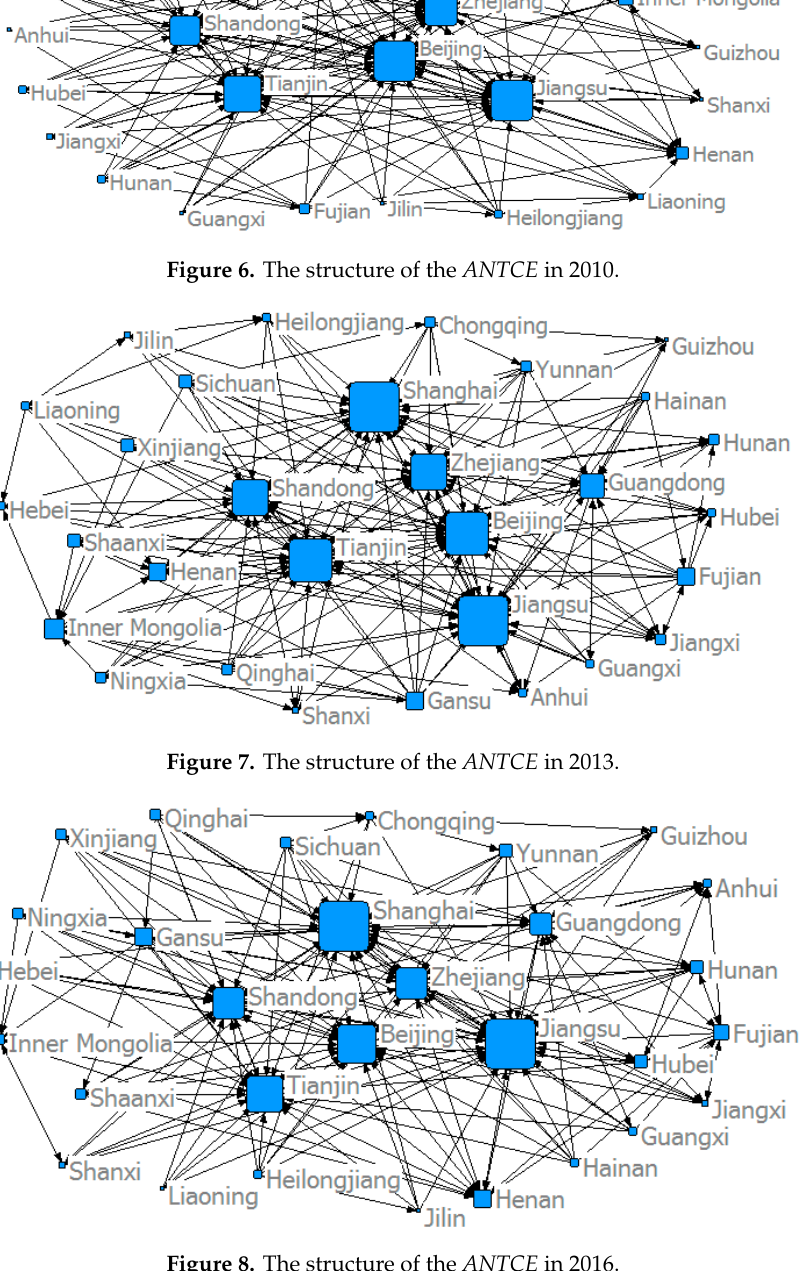
Figure 8. The structure of the ANTCE in 2016.